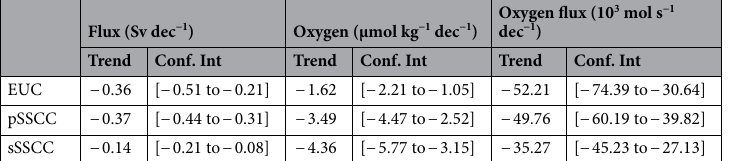
weaker than the observations (Fig. 3b). Only NCEP wind forcing drives a weak (+ 0.9 m dec −1 ) statistically sig-